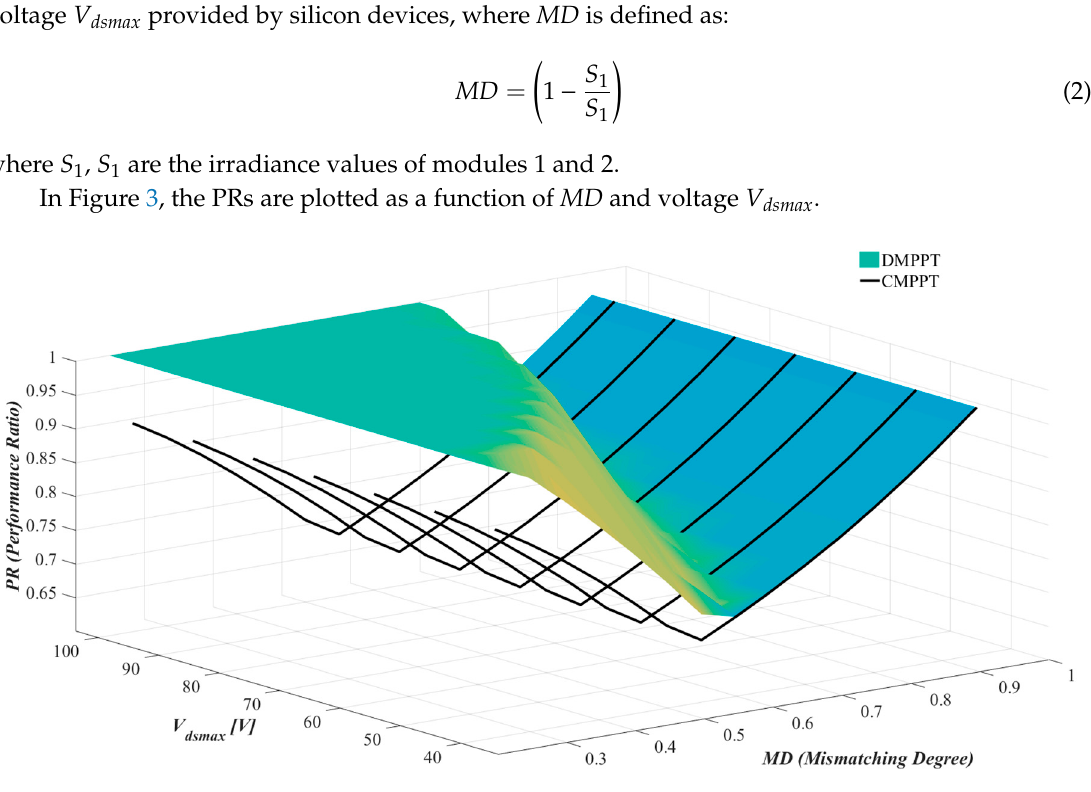
Figure 3. Performance ratio as a function of mismatching degree of the value assumed by V dsmax .